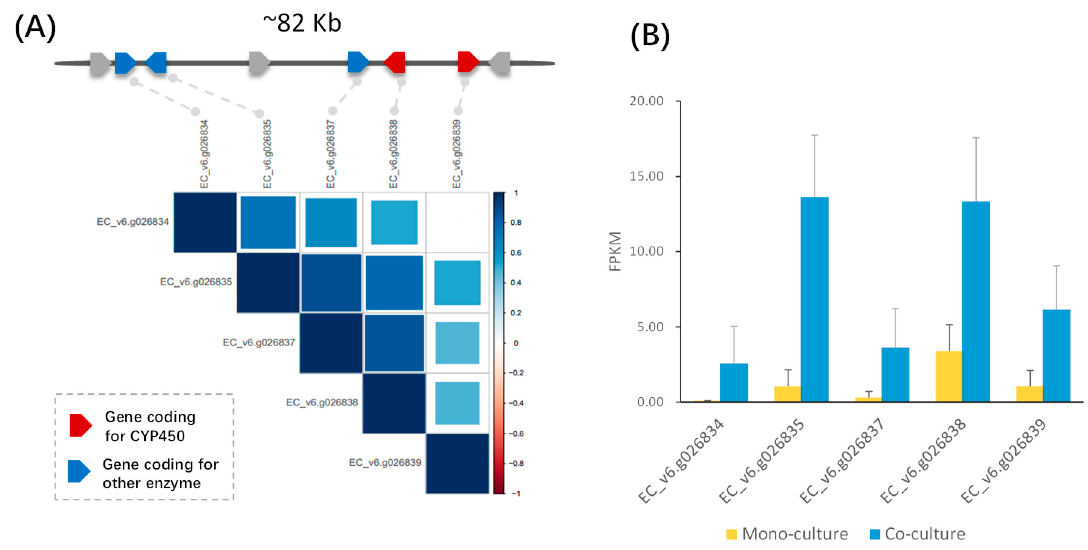
Figure 1. Characterization of the identified candidate quercetin biosynthetic gene cluster. ( A ) Gene co-expression pattern for the genes in the candidate gene cluster. ( B ) Expression changes of the five genes in the quercetin gene cluster in barnyardgrass before and after co-cultured with rice. The expression data are based on our previous RNA-Seq experiment with three biological replicates [4].